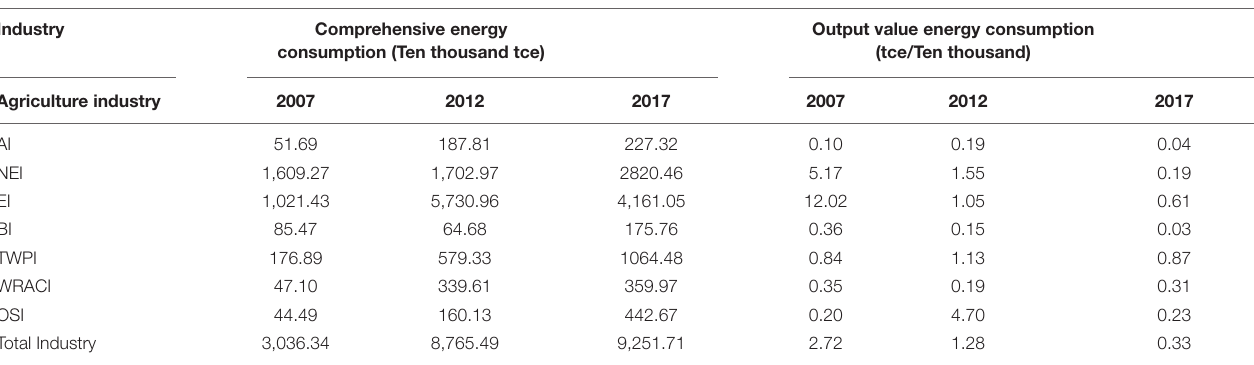
TABLE 2 | Energy consumption in 2007, 2012, and